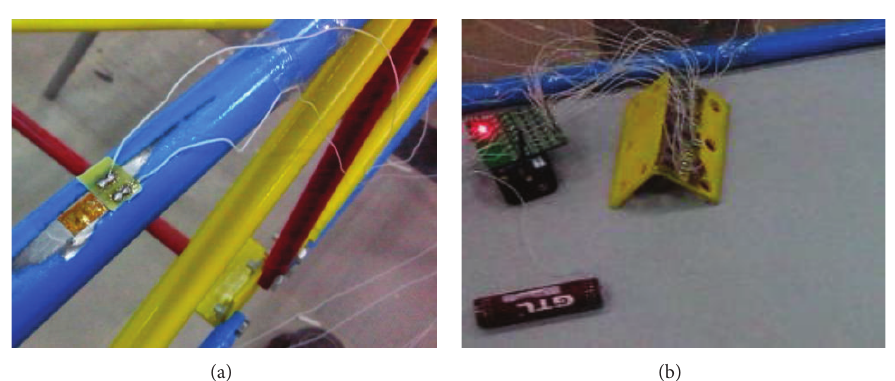
Figure 22: The arrangement of the measure points.